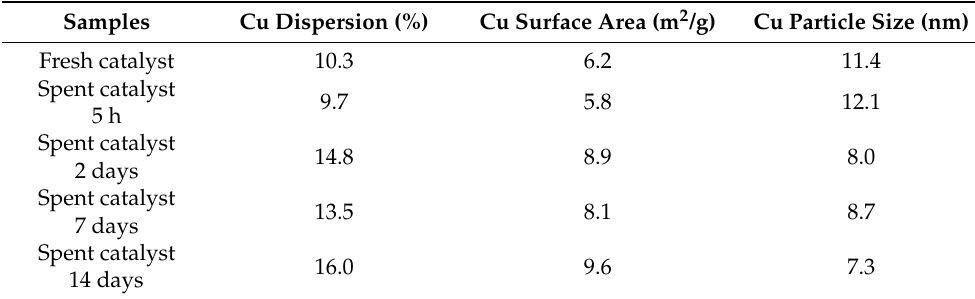
Table 6. Cu dispersion, surface area, and particle